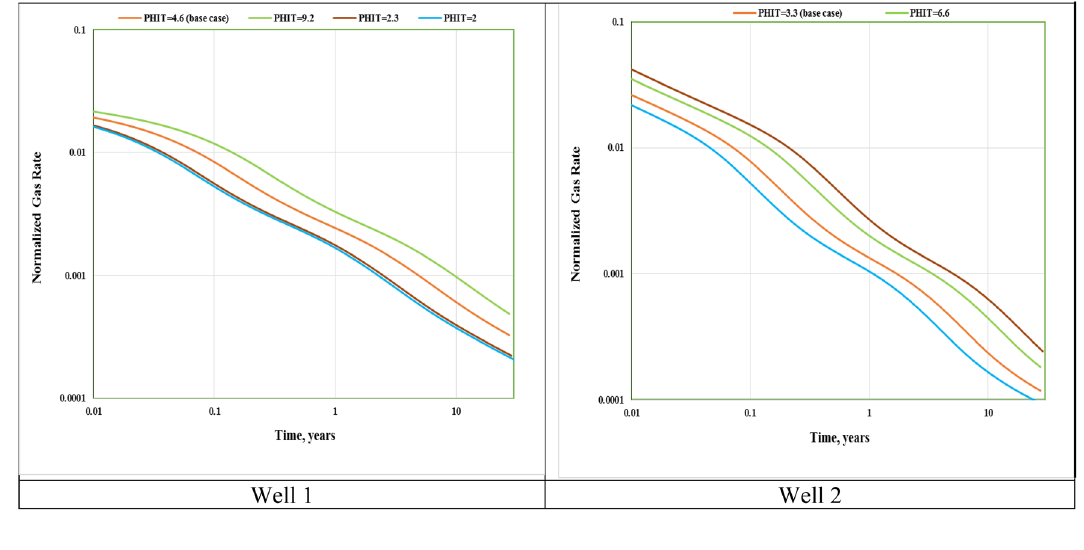
Fig. 16 Porosity sensitivity